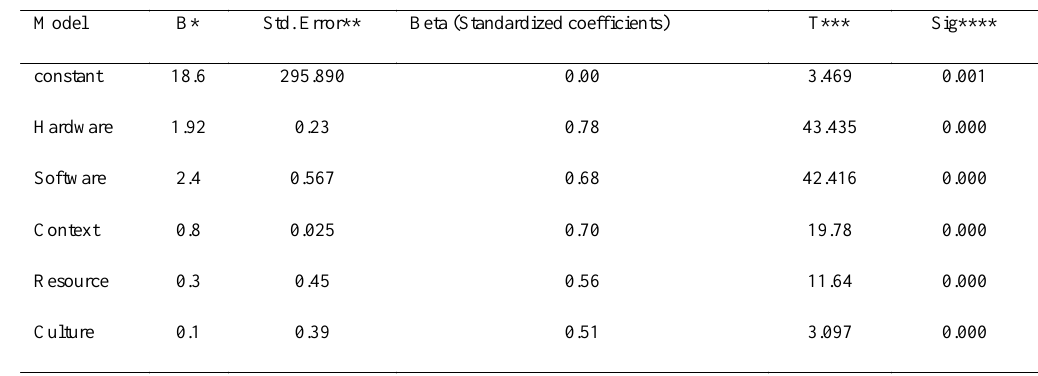
Table 4: Table of